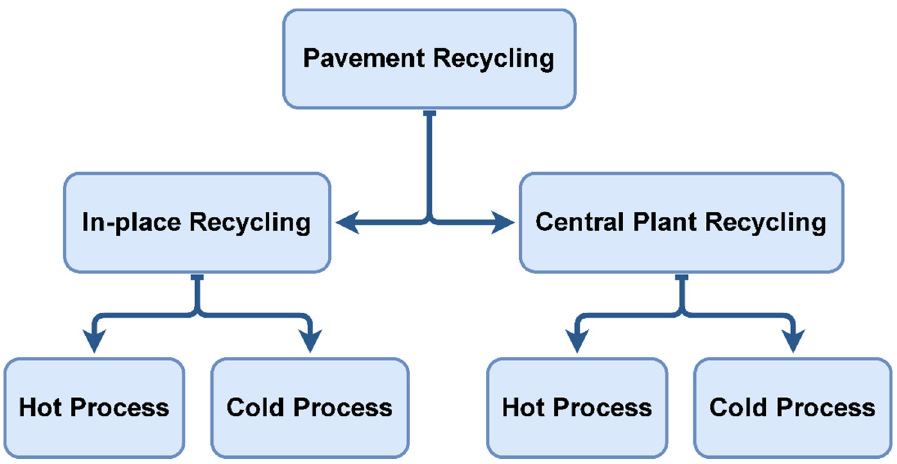
Figure 2. Classification of asphalt pavement recycling methods.